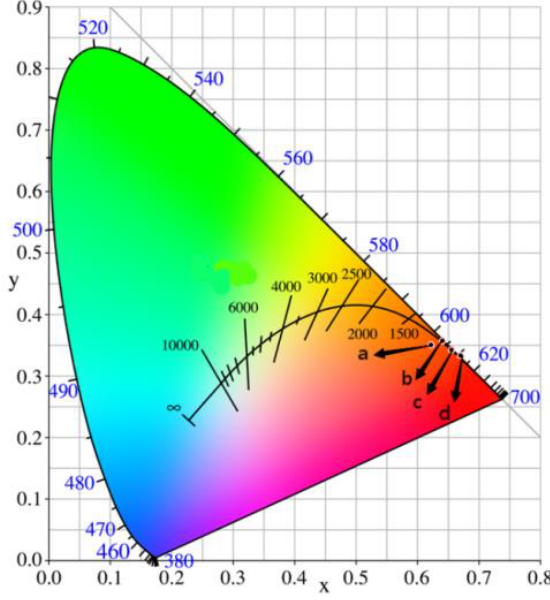
Figure 13. CIE color coordinates of Y 2 O 2 S:Eu 2+ ( a ), Sr 0.99 − x Mo 0.5 W 0.5 O 4 :0.01Eu 3+ ( b ), Sr 0.99 Mo 0.5 W 0.5 O 4 : 0.01Eu 3+ , 0.03NH 4+ ( c ) and ideal red light ( d